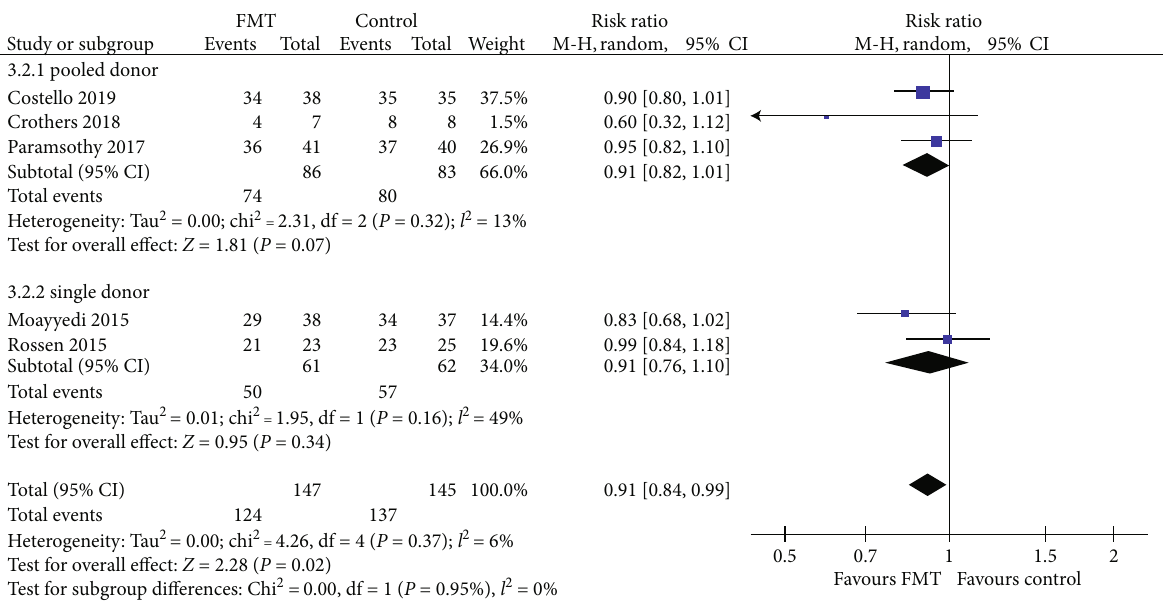
Figure 10: Forest plot of studies reporting endoscopic remission and subgroup analysis according to number of